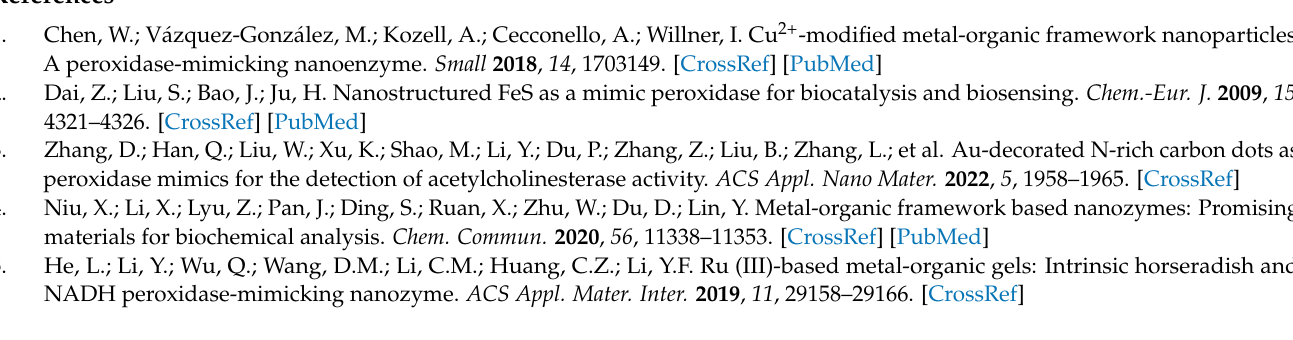
Figure S2: The UV absorption (405 nm) of (1) 2-methylimidazole + ATCh + DTNB, (2) C 4 H 6 O 4 Zn · 2H 2 O + ATCh + DTNB, (3) ZIF-8 + DTNB, (4) ZIF-8 + ATCh + DTNB. Buffer pH, 8.0; the volume of ZIF-8, 80 µ L; reaction temperature, 50 ◦ C; ATCh concentration, 5.17 mM; DTNB concentration, 1.38 mM; cen- trifugation time, 2 min; 2-methylimidazole concentration, 17.2 mM; C 4 H 6 O 4 Zn · 2H 2 O concentration, 17.2